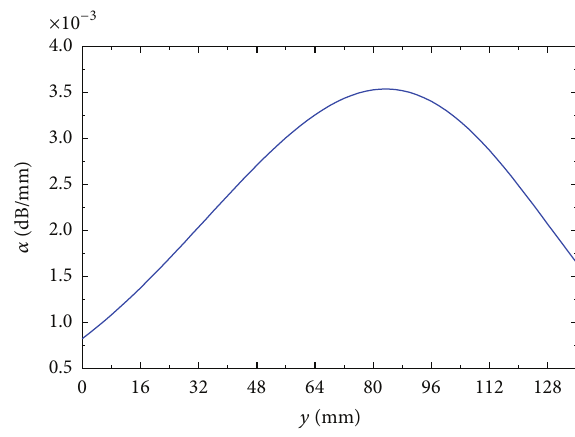
Figure 5: Distribution of 𝛼(𝑦)